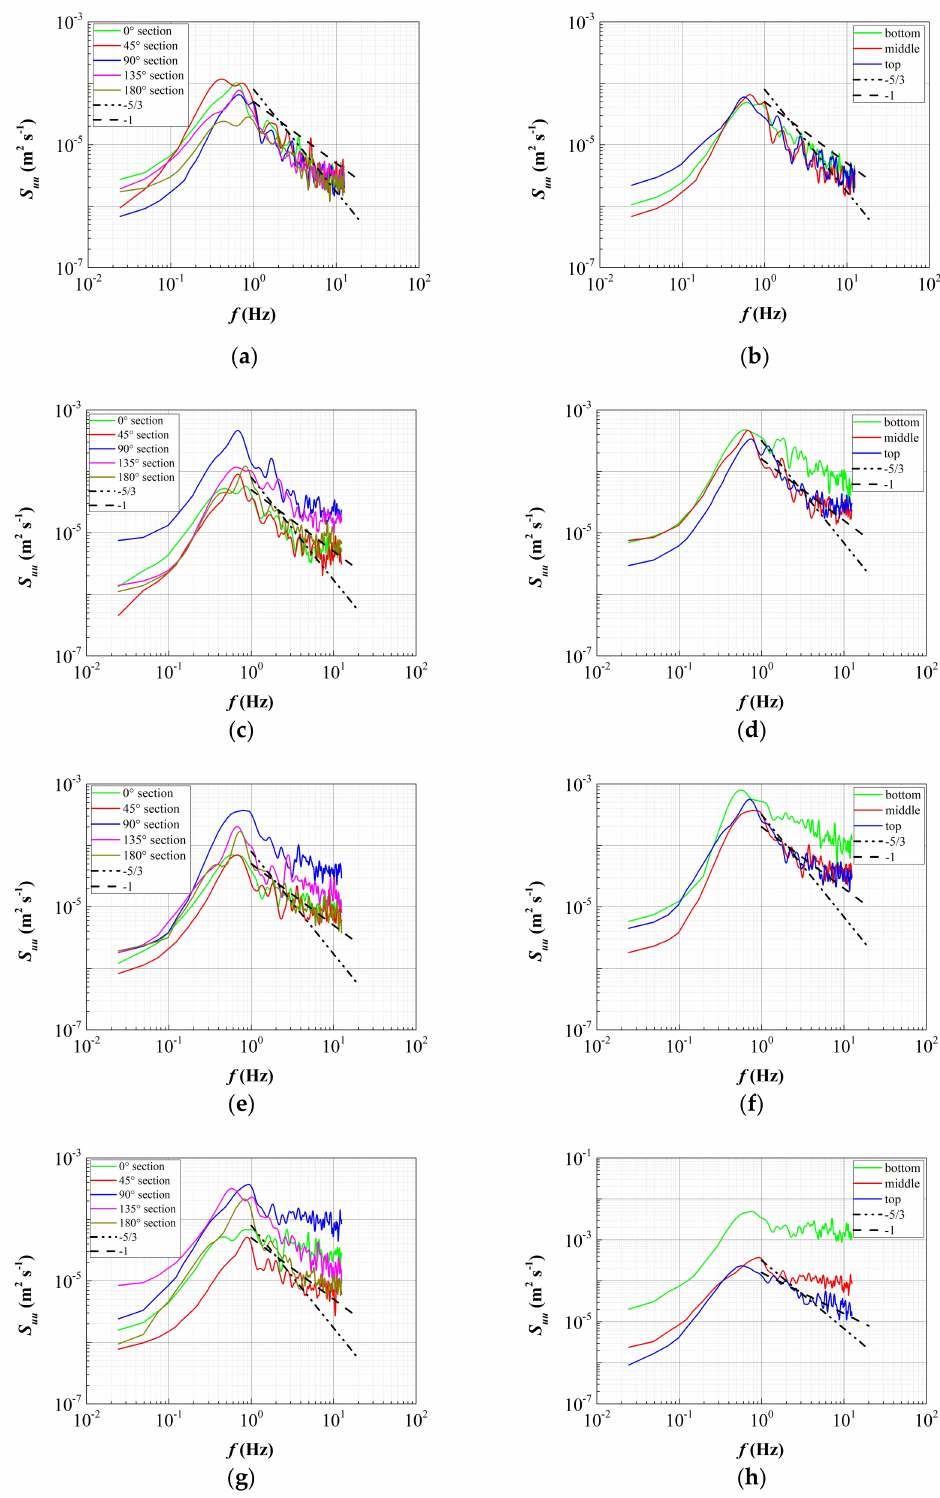
Figure 5. Power spectral density for different cases: ( a ) bare case, ( b ) different depth (2 cm, 12 cm, 16 cm) from bed for the bare case of 90 ◦ section, ( c ) small case, ( d ) different depth (2 cm, 12 cm, 16 cm) from bed for the small case of 90 ◦ sectioI ( e ) middle case, ( f ) different depth (2 cm, 12 cm, 16 cm) from bed for the middle case of 90 ◦ section, ( g ) big case, ( h ) different depth (2 cm, 12 cm, 16 cm) from bed for the big case of 90 ◦